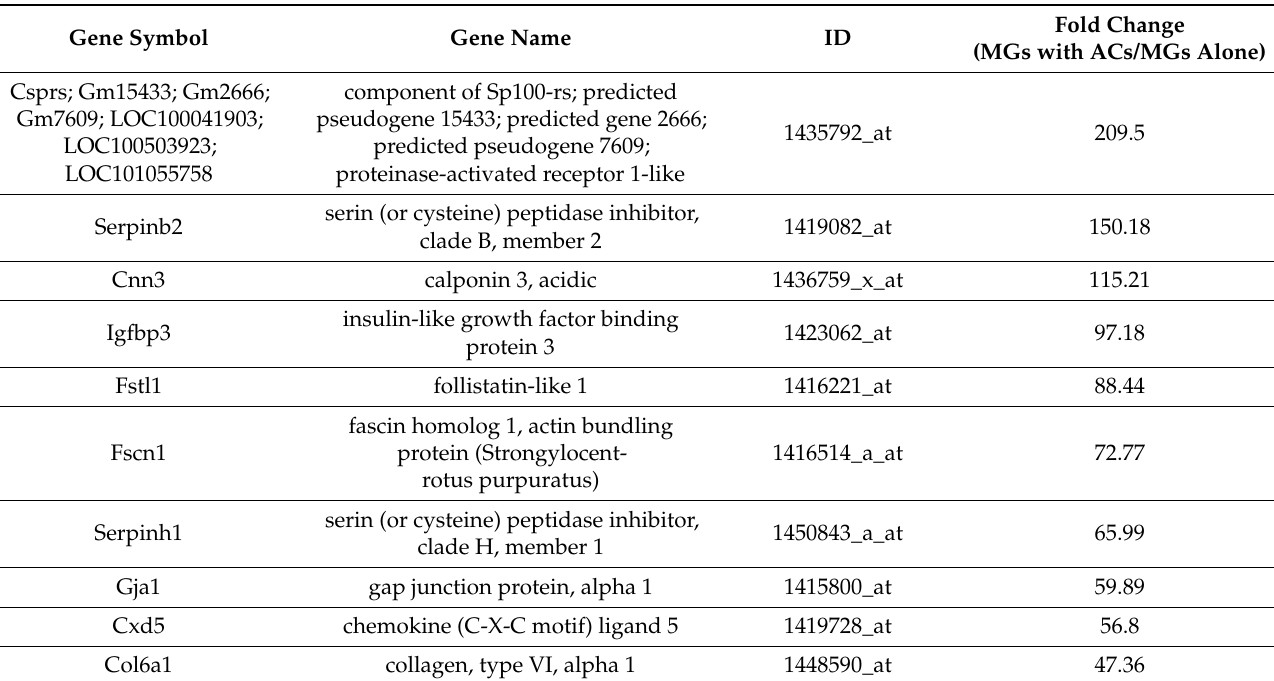
Table 3. List of top 10 highly expressed genes in MGs with PCs compared with MGs alone.